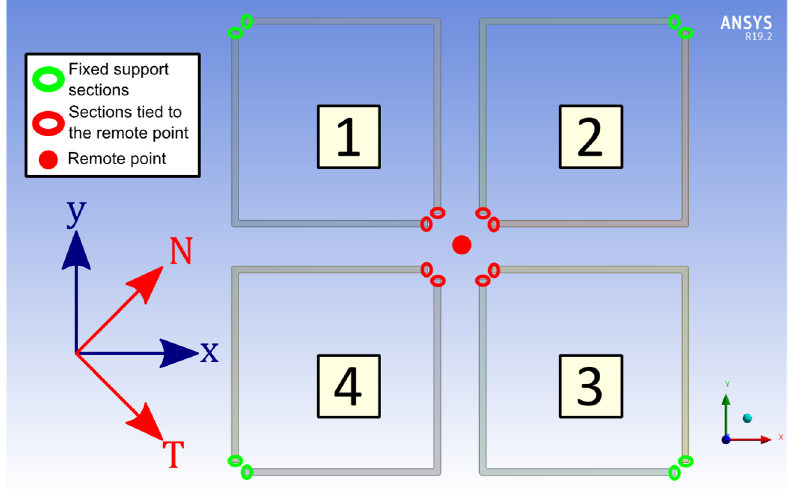
Figure 2. Model used during simulations.